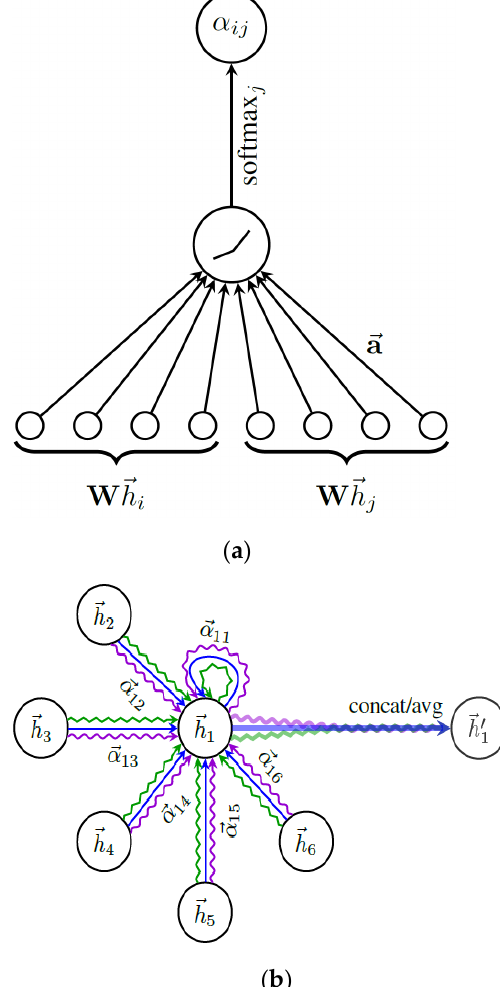
Figure 2. Graphic illustration of the attention mechanism [46]. ( a ) Extracting features from neighborhood vertices; ( b ) Multi-head attention method.